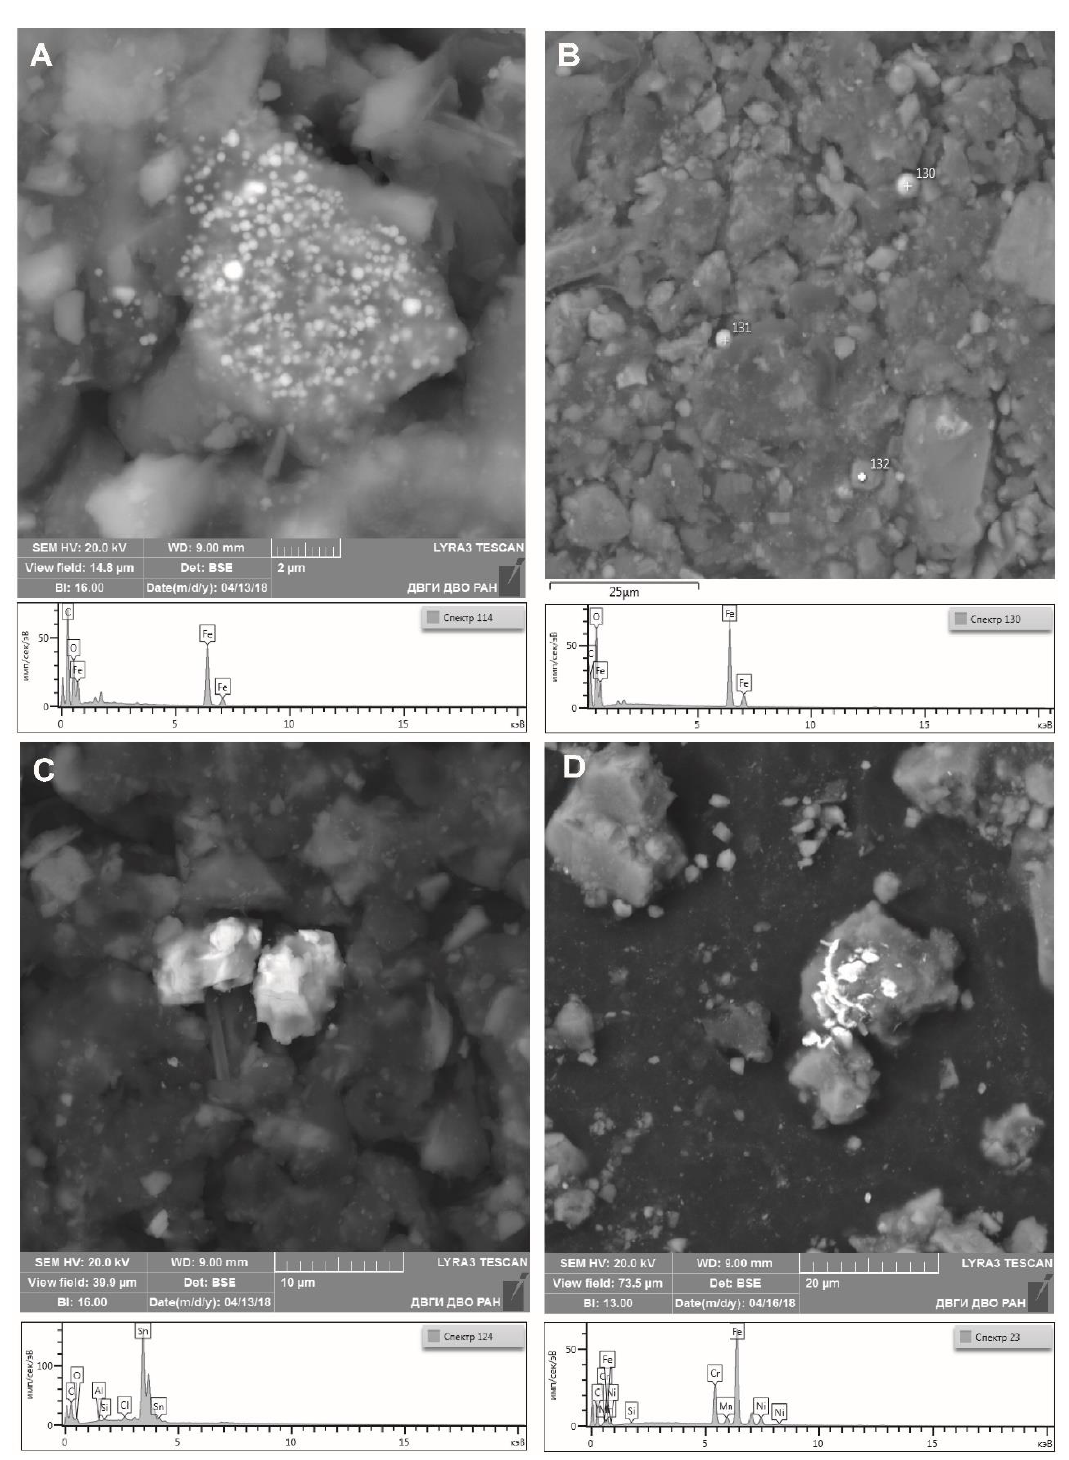
Figure 5. Morphology and chemical composition of Fe, Sn, Cr, and Ni dust particles represented by: ( A , B ) magnetite (sample No. 2); ( C ) cassiterite (sample No. 2), and ( D ) iron-chromium-nickel minerals (sample No. 3).